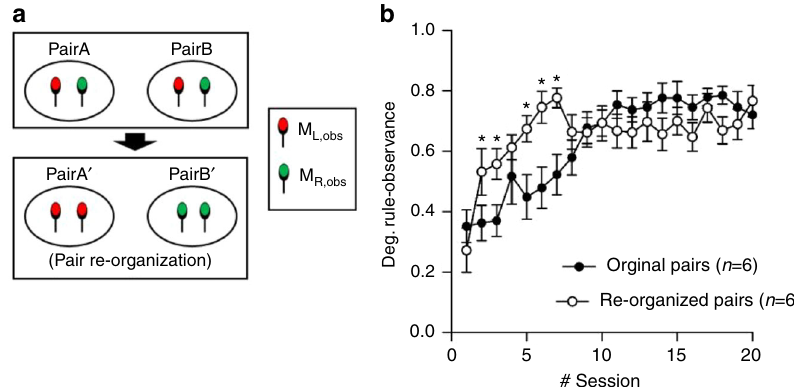
Fig. 5 Rapid transfer of the reward allocation rule in the re-organized pairs. a From two M Obs – M Obs pairs which have completed 20 sessions of the con fl ict resolution tests, the mice preferring the same side of the reward zone were chosen and subjected (M L with M L , M R with M R ) to perform con fl ict resolution test for another 20 sessions. b Degree of rule-observance along the sessions. In the re-organized pairs, the degree of rule-observance more rapidly increased compared to the learning curve of the original pairs. The increase was the most dramatic between the fi rst and the second session (two-way RM ANOVA, F 19,209 = 3.445, P < 0.001, Holm – Sidak post hoc test * P